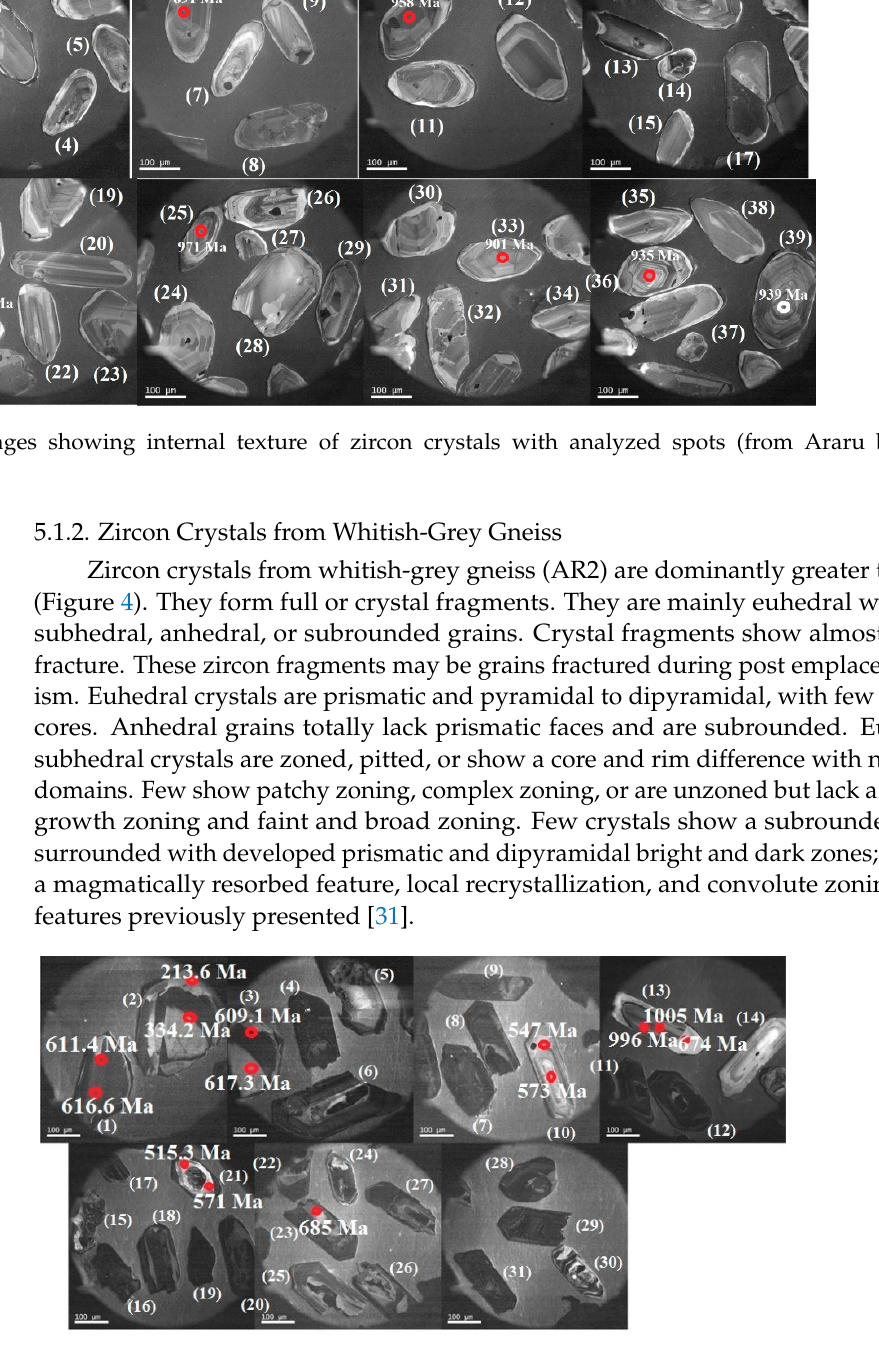
Figure 4. BSE-CL images showing internal texture of zircon crystals with analyzed spots (from Araru whitish-grey gneiss).